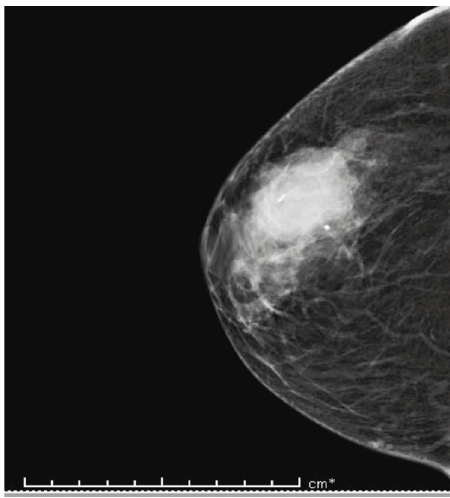
Figure 1: Mammography of the lesion showing a 3-4 cm central mass with no calci fi